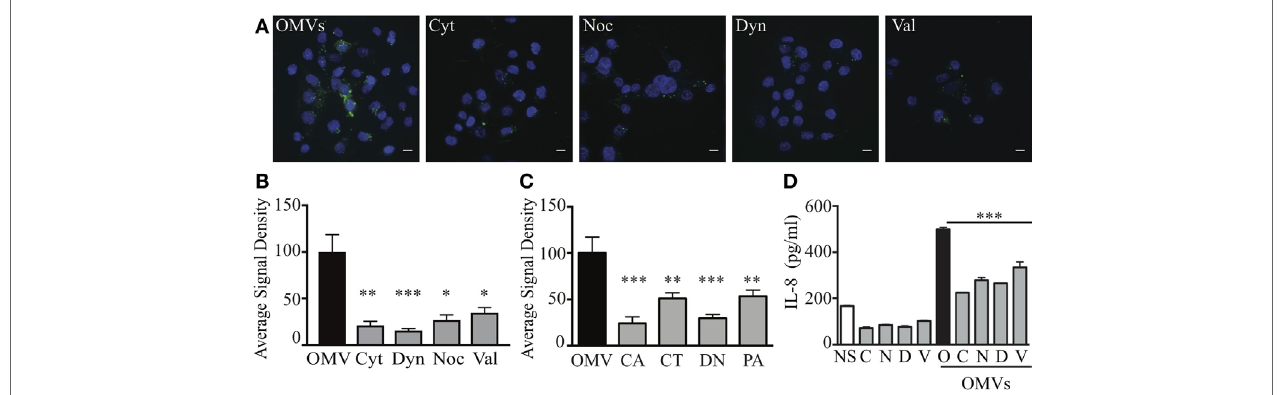
FigUre 1 | Heterogeneous sized outer membrane vesicles (OMVs) enter host cells via macropinocytosis, clathrin, caveolin, and dynamin-dependent endocytosis. (a,B) AGS cells were treated with cytochalasin D (Cyt), nocodazole (Noc), dynasore (Dyn), valinomycin (Val), or left untreated (OMV), prior to co-culture with DiO (green) labeled heterogeneous populations of OMVs. Nuclear DNA was stained with DAPI (blue) to allow enumeration of cells. Extracellular fluorescence was quenched with trypan blue. (c) The average signal density of internalized green fluorescent OMVs (OMVs) into cells pre-treated with siRNAs to specifically inhibit caveolin (CA), clathrin (CT), dynamin (DN), or macropinocytosis (PA) was measured and normalized to OMV alone group treated with control siRNA. (D) IL-8 production in AGS cells that were non-stimulated (NS, open bars), stimulated with OMVs alone as a control (black bar), or pre-treated with chemical inhibitors cytochalasin D (C), nocodazole (N), dynasore (D), valinomycin (V) (gray bars) prior to co-culture with OMVs. Data are represented as mean ± SEM of three replicate experiments. Line indicates statistical significance compared to OMV control group. Images are representative of three-independent experiments in which > 100 cells were counted per treatment (a) , or pooled from three-independent experiments (B–D) . Error bars indicate ± SEM of > 100 cells. * P < 0.05, ** P < 0.01, *** P <